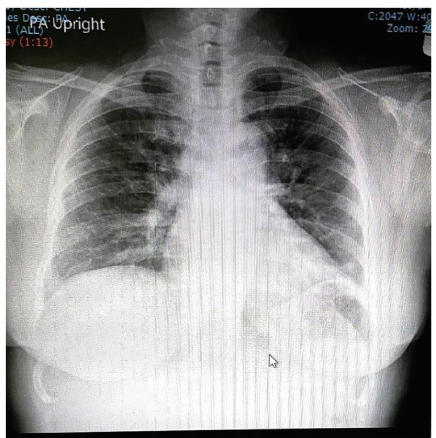
Figure 2: Chest radiography on